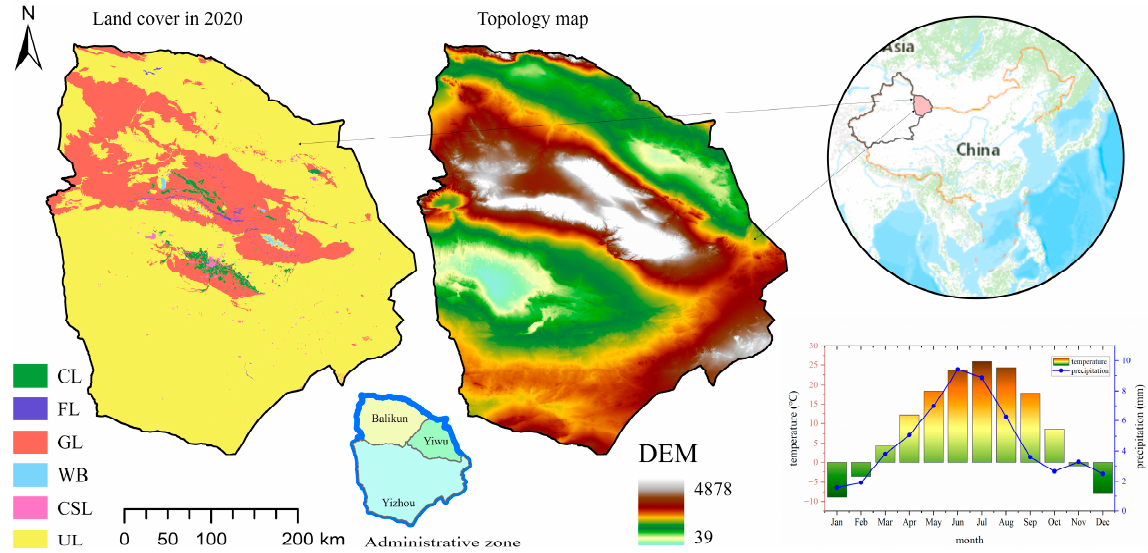
Figure 1. Study area. The left one shows the land use/cover (CL, FL, GL, WB, CSL and UL are cropland, forest, grassland, water body, construction land and unused land, respectively) of the study area, the middle one is the digital elevation model of Hami city, the lower-right graph shows the mean monthly temperature and mean monthly precipitation of Hami city.